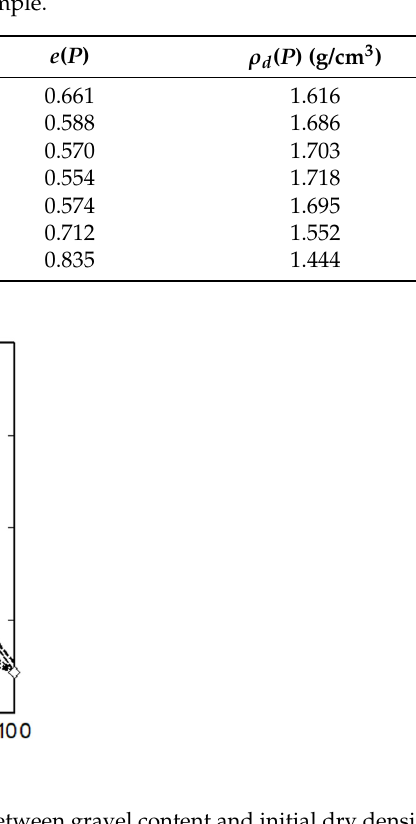
Figure 4. Relationship between various values of Rm between gravel content and initial dry density.